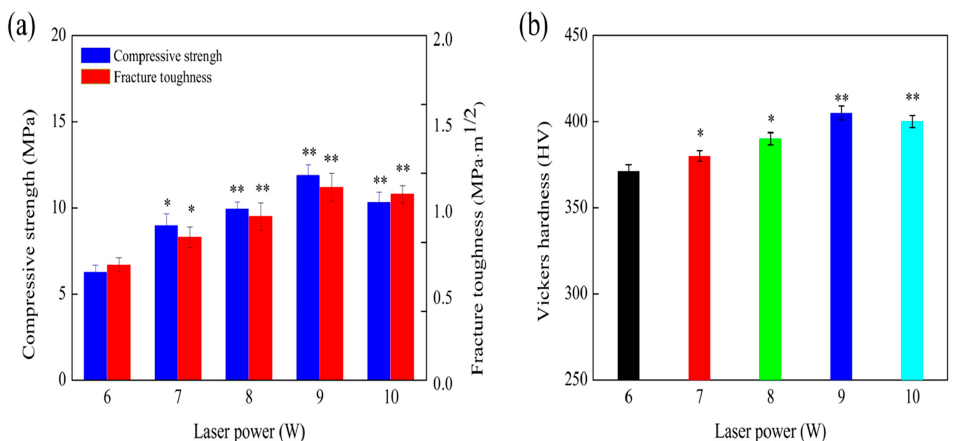
Figure 3. ( a ) Compressive strength and fracture toughness and ( b ) Vickers hardness of TTCP scaffolds sintered at 6, 7, 8, 9, and 10 W.